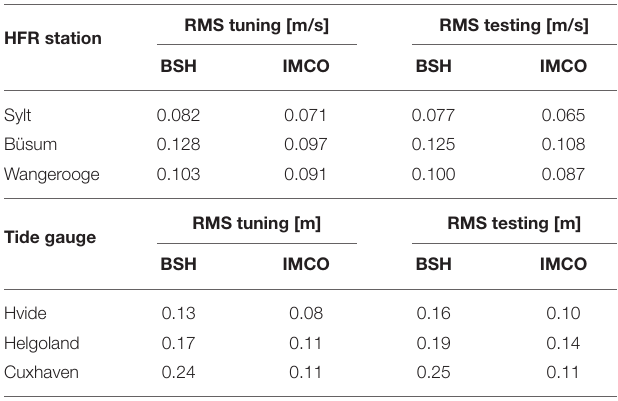
TABLE 2 | RMS differences between observed HFR radial components and respective simulations from the BSH model and IMCO model. HFR